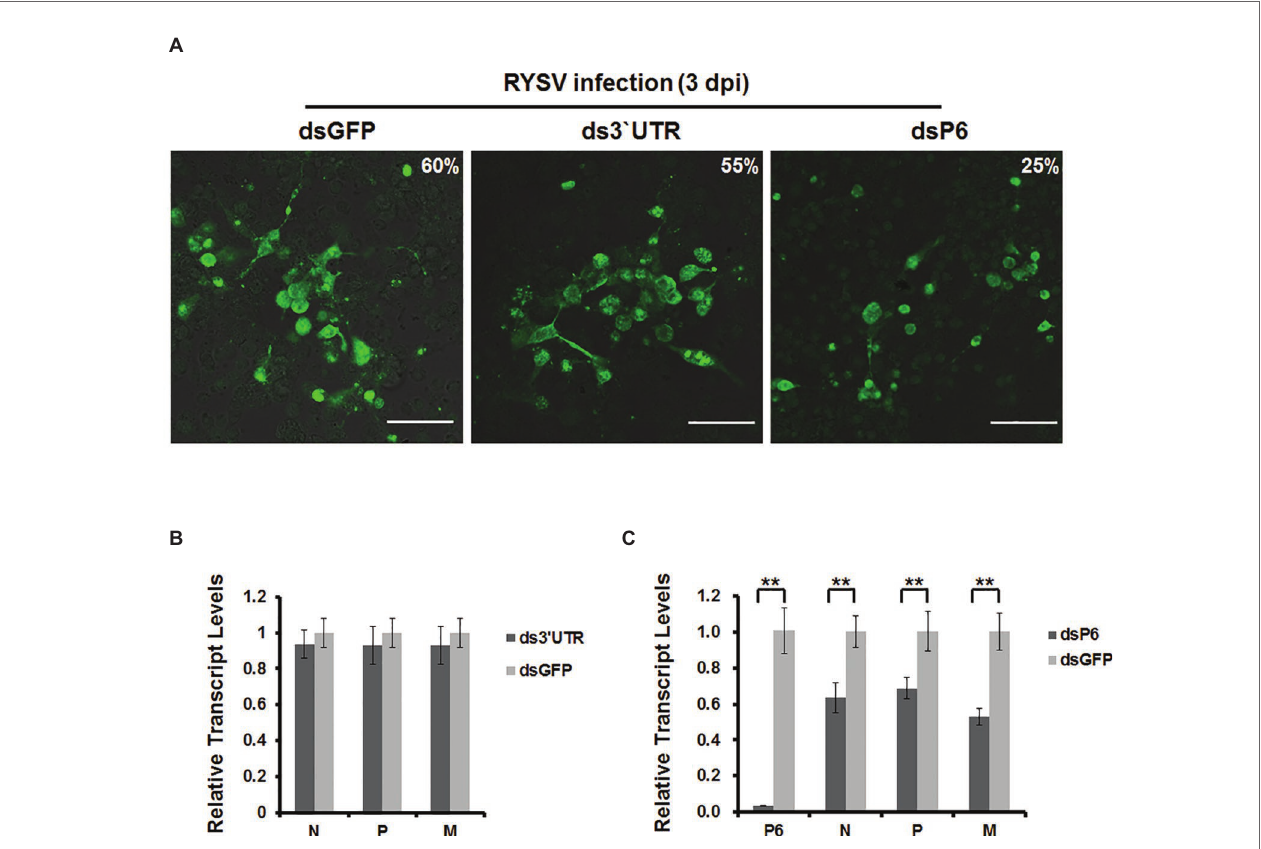
FIGURE 6 | Knockdown of P6 by dsRNA treatment affects RYSV infection. (A) VCMs were first transfected with dsGFP , ds3 ′ UTR , or dsP6 and then inoculated with RYSV. At 72 h post RYSV inoculation, cells were immunolabeled with antibodies specific to N protein and subjected to confocal microscope observation. Scale bar: 25 μm. A total of 1,200 cells/condition were counted. (B) qRT-PCR analysis of RYSV N , P , and M gene transcripts after treatment with ds3 ′ UTR treatment. The RYSV- infected cells were also treated with dsGFP as the control. (C) qRT-PCR analysis of RYSV N , P , and M gene transcripts after treatment with dsP6 and dsGFP . Three biological repeats were done for each experiment. Data represent means ±SD and were analyzed using Student’s t test; significance levels: * p < 0.05; ** p <